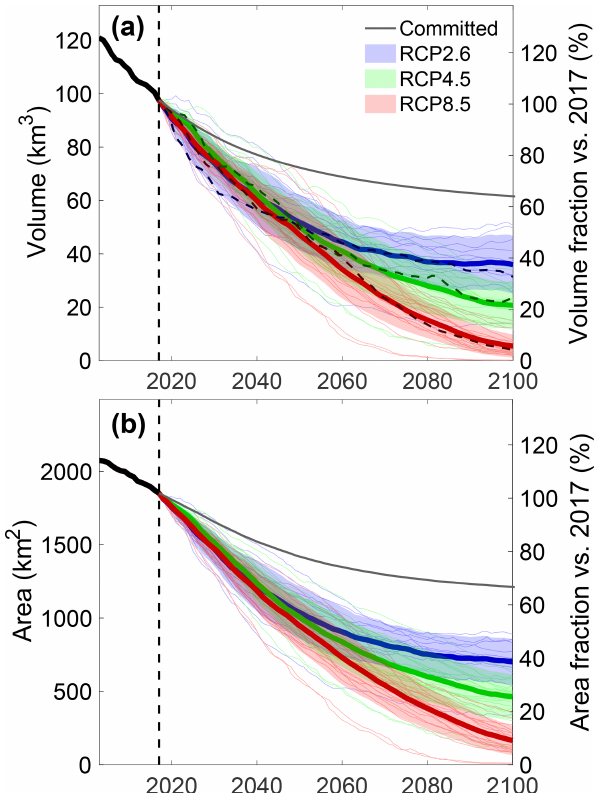
Figure 8. Ensemble (a) volume and (b) area evolution for vari- ous EURO-CORDEX RCM simulations and committed loss (mean 1988–2017 conditions). Thin lines are individual RCM simulations (51 in total, see Table S1). The thick line is the RCP mean and the transparent bands correspond to one standard deviation. In (a) , the coloured dotted lines correspond to the model simulations that are closest to the multi-model mean. The vertical dotted line represents the year 2017 and marks the transition between E-OBS and EURO- CORDEX